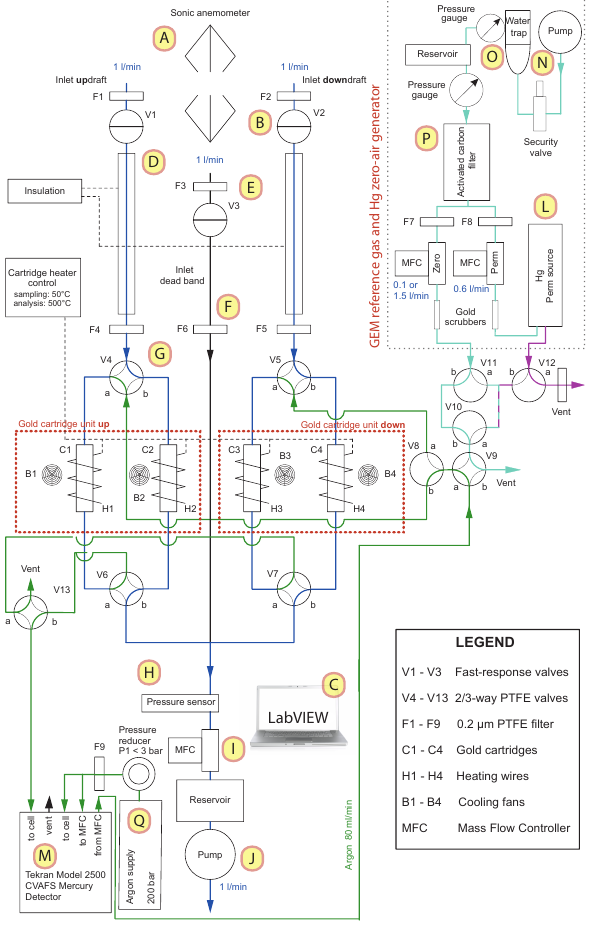
Figure 1. Schematic of the REA system hardware. It consists of a GEM sampling unit, a GEM reference gas generator and a Hg zero-air generator (upper right). Capital letters refer to REA com- ponents mentioned in the text and described in Table S1. The air volume drawn over the gold cartridges equaled 1Lmin − 1 in Basel and 1.5Lmin − 1 at